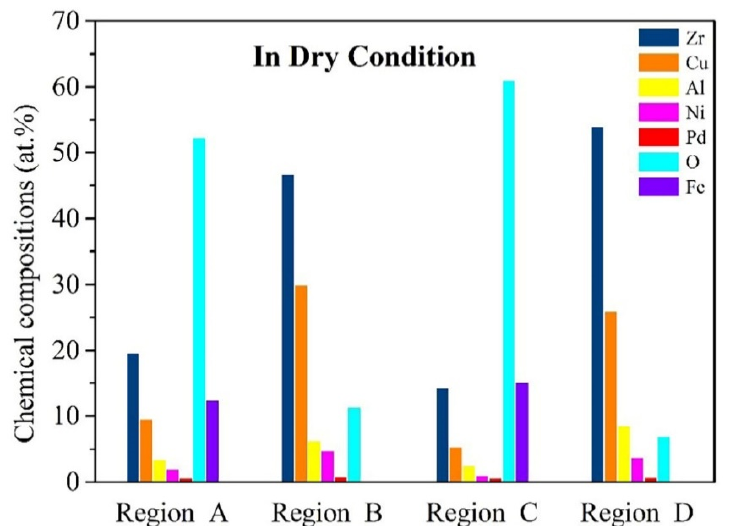
Figure 8. Chemical compositions of typical regions on the worn scar of as-cast and treated BMGs in dry-sliding.